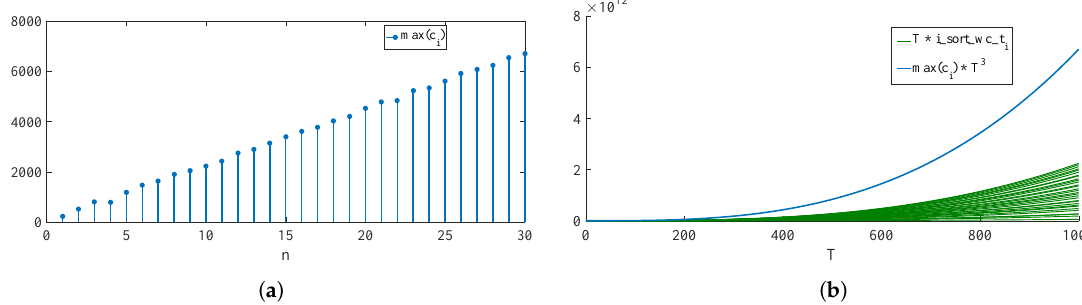
Figure 7. Asymptotic behavior of the ELF algorithm for increasing cost functions. ( a ) Cost function of n ≤ 30 schedulers; ( b ) Asymptotic growth of n ≤ 30